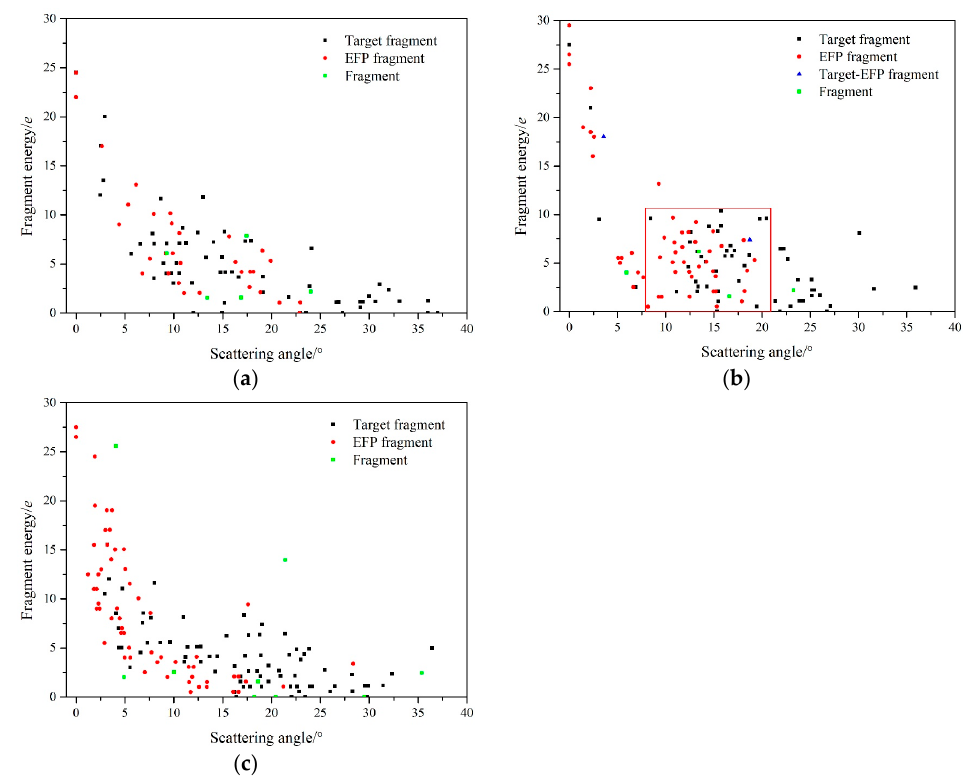
Figure 12. Relationship between energy and scattering angle of the BAD. ( a ) L / D = 1.66 ( b ) L / D = 2.4 ( c ) L / D = 3.86.